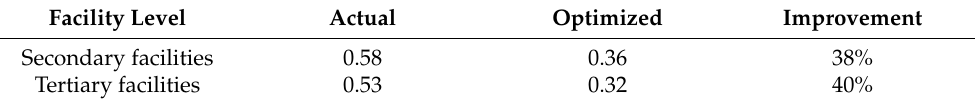
Table 3. The coefficients of variation in actual and optimized healthcare accessibility.